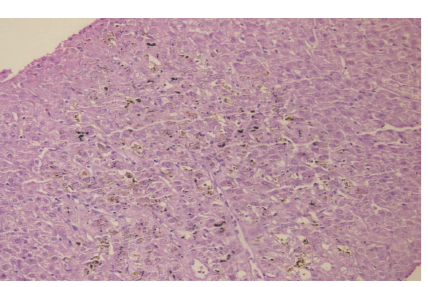
Figure 1: Biopsy material of